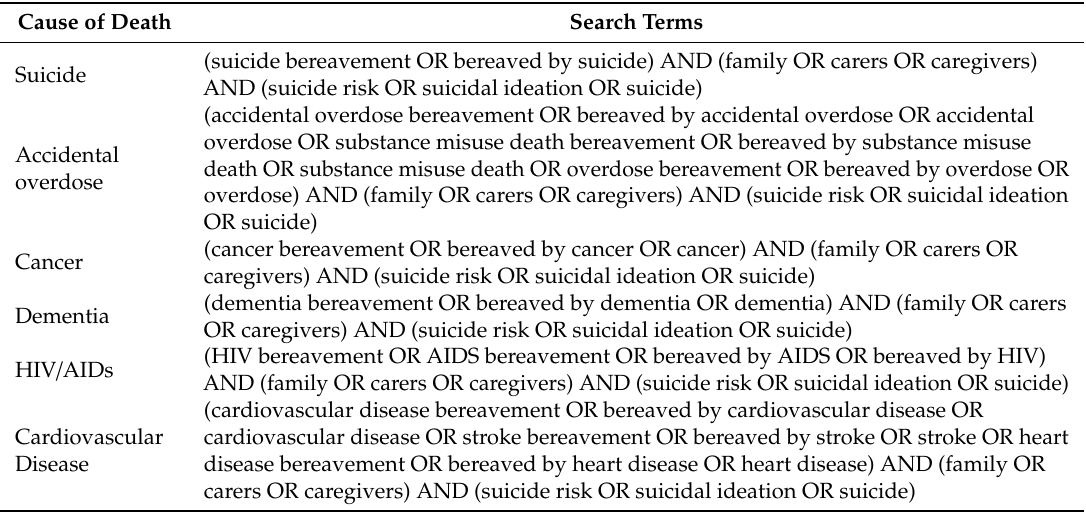
Figure 1. Flow diagram of search process guided by the PRISMA statement [15].